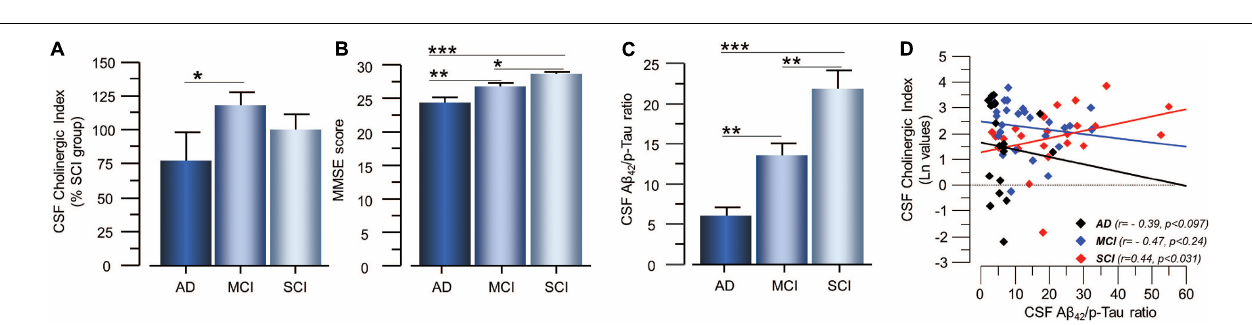
FIGURE 4 | Estimated Cholinergic Index in CSF of patients in different stages of dementia and its relation to cognition and the CSF A β 42 /p-tau ratio. (A) The estimated CSF Cholinergic index (ChAT F /AChE F ) was highest in the MCI group. (B) The global cognitive performance of the patients as assessed by MMSE test shows the expected pattern. (C) The CSF A β 42 /p-tau ratio also follows the expected pattern of lowest in AD and highest in SCI. (D) The CSF Cholinergic index showed differential correlation with the CSF A β 42 /p-tau ratio in SCI and AD. In panel (D) , the CSF Cholinergic index is given in natural logarithm (Ln). The CSF Cholinergic index is defined as a ratio between the functional levels of ChAT (in nmol/min/ µ g) and the functional levels of AChE (in nmol/min/ µ g) in CSF (i.e., ChAT F /AChE F activities). AChE = acetylcholinesterase; AD = Alzheimer’s disease; ChAT = choline acetyltransferase; CSF = cerebrospinal fluid; MCI = mild cognitive impairment; p-tau = phosphorylated tau 181. SCI = subjective cognitive impairment. * p < 0.05, ** p < 0.01, and *** p < 0.001.